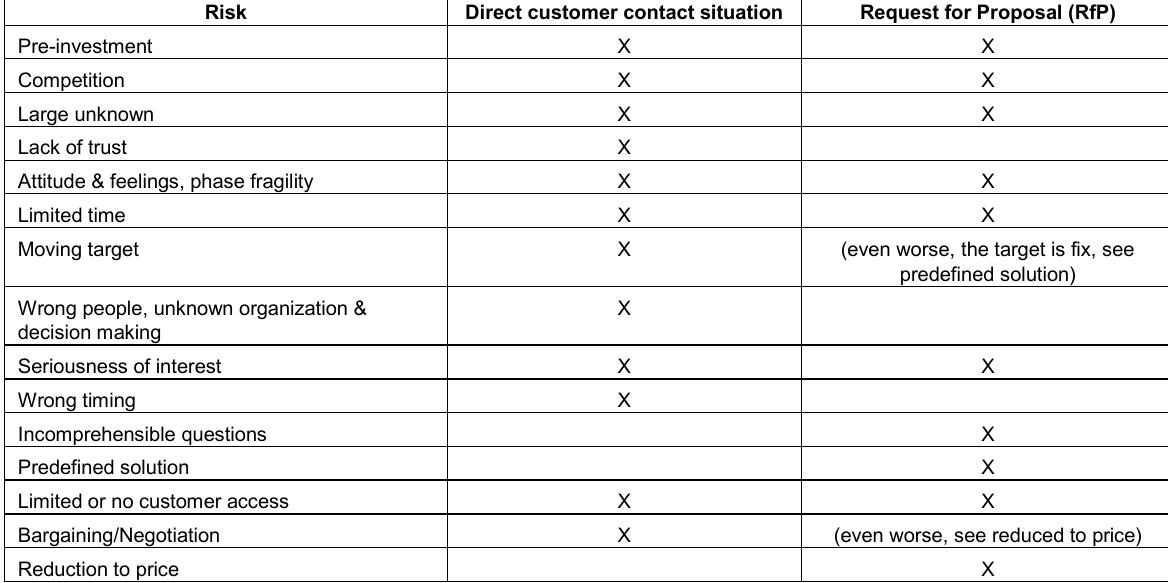
Table 1. Risk overview of the pre-sales